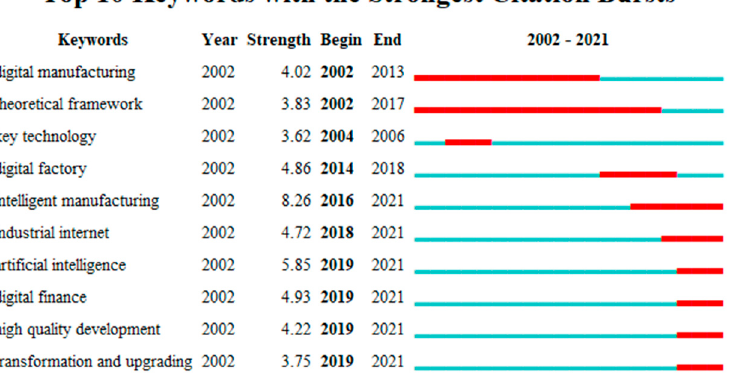
Figure 3. The sudden map of research keywords in the field of enterprise digitalization from 2002 to 2021.